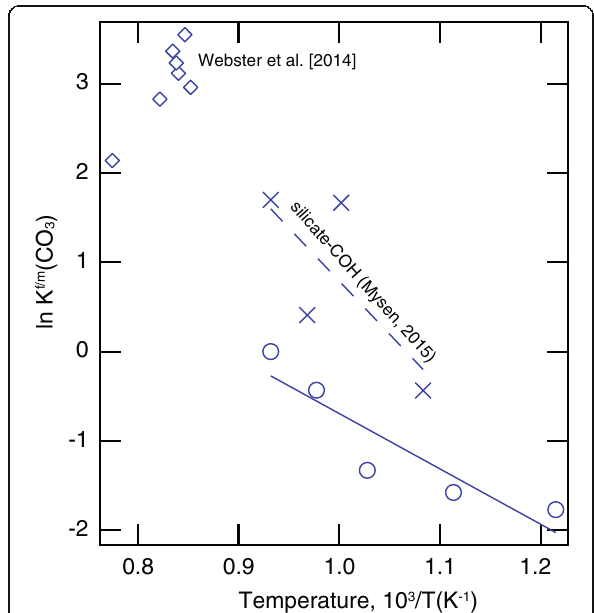
Fig. 15 Partition coefficient of CO 32 groups between coexisting fluid and melt as a function of temperature. Partition coefficients were determined as discussed under Eq. (1) in the text. The straight line fit by least squares regression yields; ln K = 6 ± 2 – 6203 ± 1620/T, r 2 = 0.83. Also shown are data from Mysen (2015a) from a silicate – COH system, also under oxidizing conditions. The dashed lines represents a least squares linear fit through those data, with the expression ln(CO 32- /HCO 3- ) = − 11,893 ± 7610/T + 13 ± 8, r 2 = 0.74 as well as data from Webster et al. (2014) using natural silicate melts and COH fluids that also contains halogens and